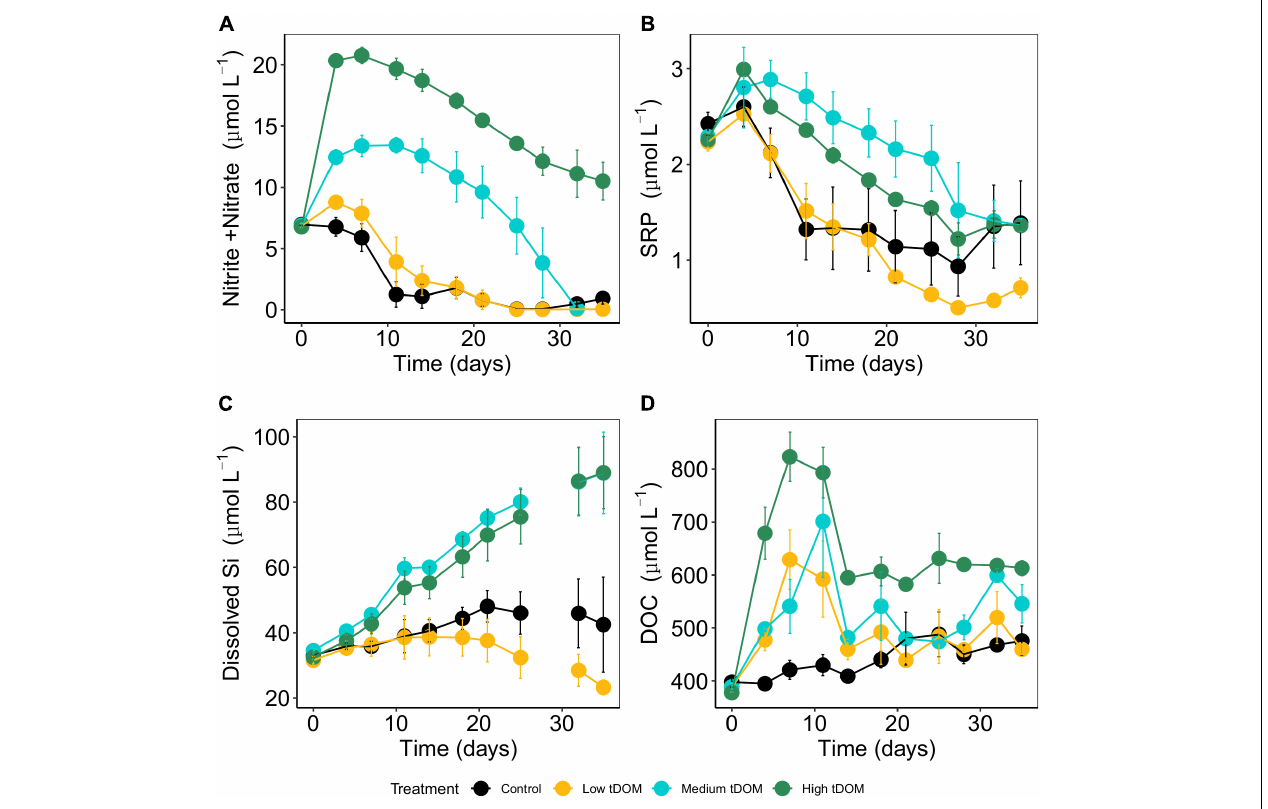
FIGURE 2 | Inorganic nutrient concentrations over 35 days of the experiments: (A) dissolved inorganic nitrogen (nitrate + nitrite), (B) soluble reactive phosphorus (SRP), and (C) dissolved silicate. Panel (D) represents the concentration of dissolved organic carbon (DOC). Error bars represent standard deviation. Color plots represent tDOM addition in the control (black), low tDOM (yellow), medium tDOM (blue), and high tDOM (green) treatments.